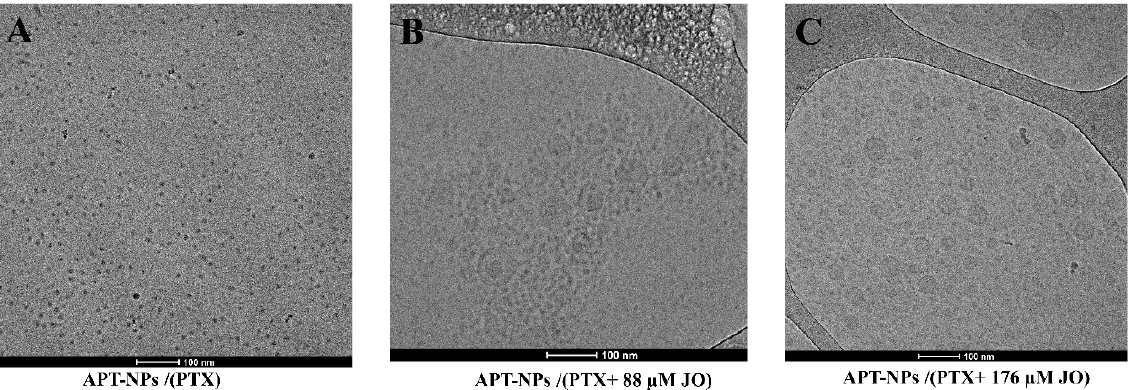
88 µ M JO; ( C ) APT-NPs encapsulating 14 µ M PTX + 176 µ M Figure 3. Cryo-TEM images of ( A ) APT-PP-NPs encapsulating 14 µM PTX; ( B ) APT-PP-NPs encapsulating 14 µM PTX + 88 µM JO; ( C ) APT-NPs encapsulating 14 µM PTX + 176 µM JO.